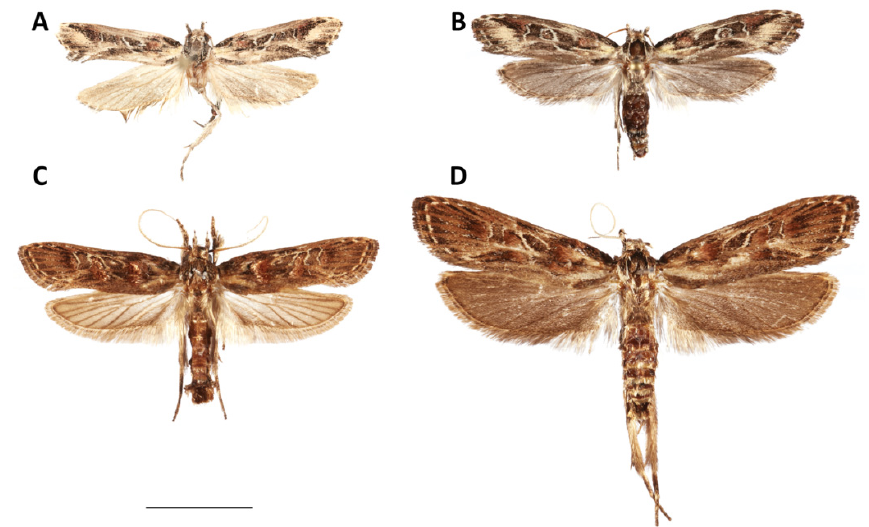
Figure 9. Dorsal view of adult ( A ) C. subagronoma , male (USNMENT01328210); ( B ) C. subagronoma , female (USNMENT01328218); ( C ) C. agronoma , male (USNMENT01200872); ( D ) C. agronoma , female (USNMENT01200871). Measure bar = 10.0 mm.